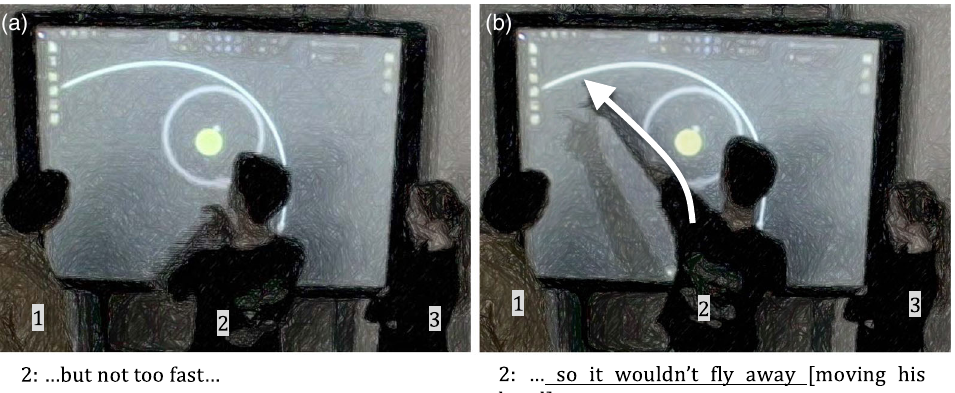
FIG. 5. The sequence of gestures is particularly interesting, because it mirrors students ’ previous interactions with the IWB. The gesture by student 2 in (a) represents the local movement of the planet. We can infer this from the accompanying student utterance. The gesture in (b), following directly the one in (a), simulates a “ touch-screen throwing ” motion with a finger — the student bends back his finger and flicks it as he retracts the hand from the screen surface (not clearly visible in the figure, but visible in the video).